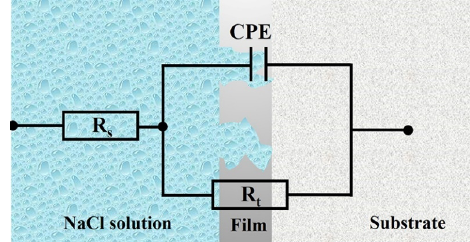
Figure 15. Equivalent circuits used for fitting the EIS. Table 5. E lectrochemical parameters of the fitting equivalent circuits.